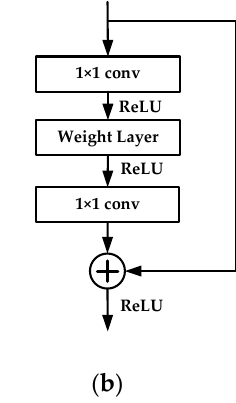
Figure 1. Residual block: ( a ) standard residual block; ( b ) residual bottleneck block.